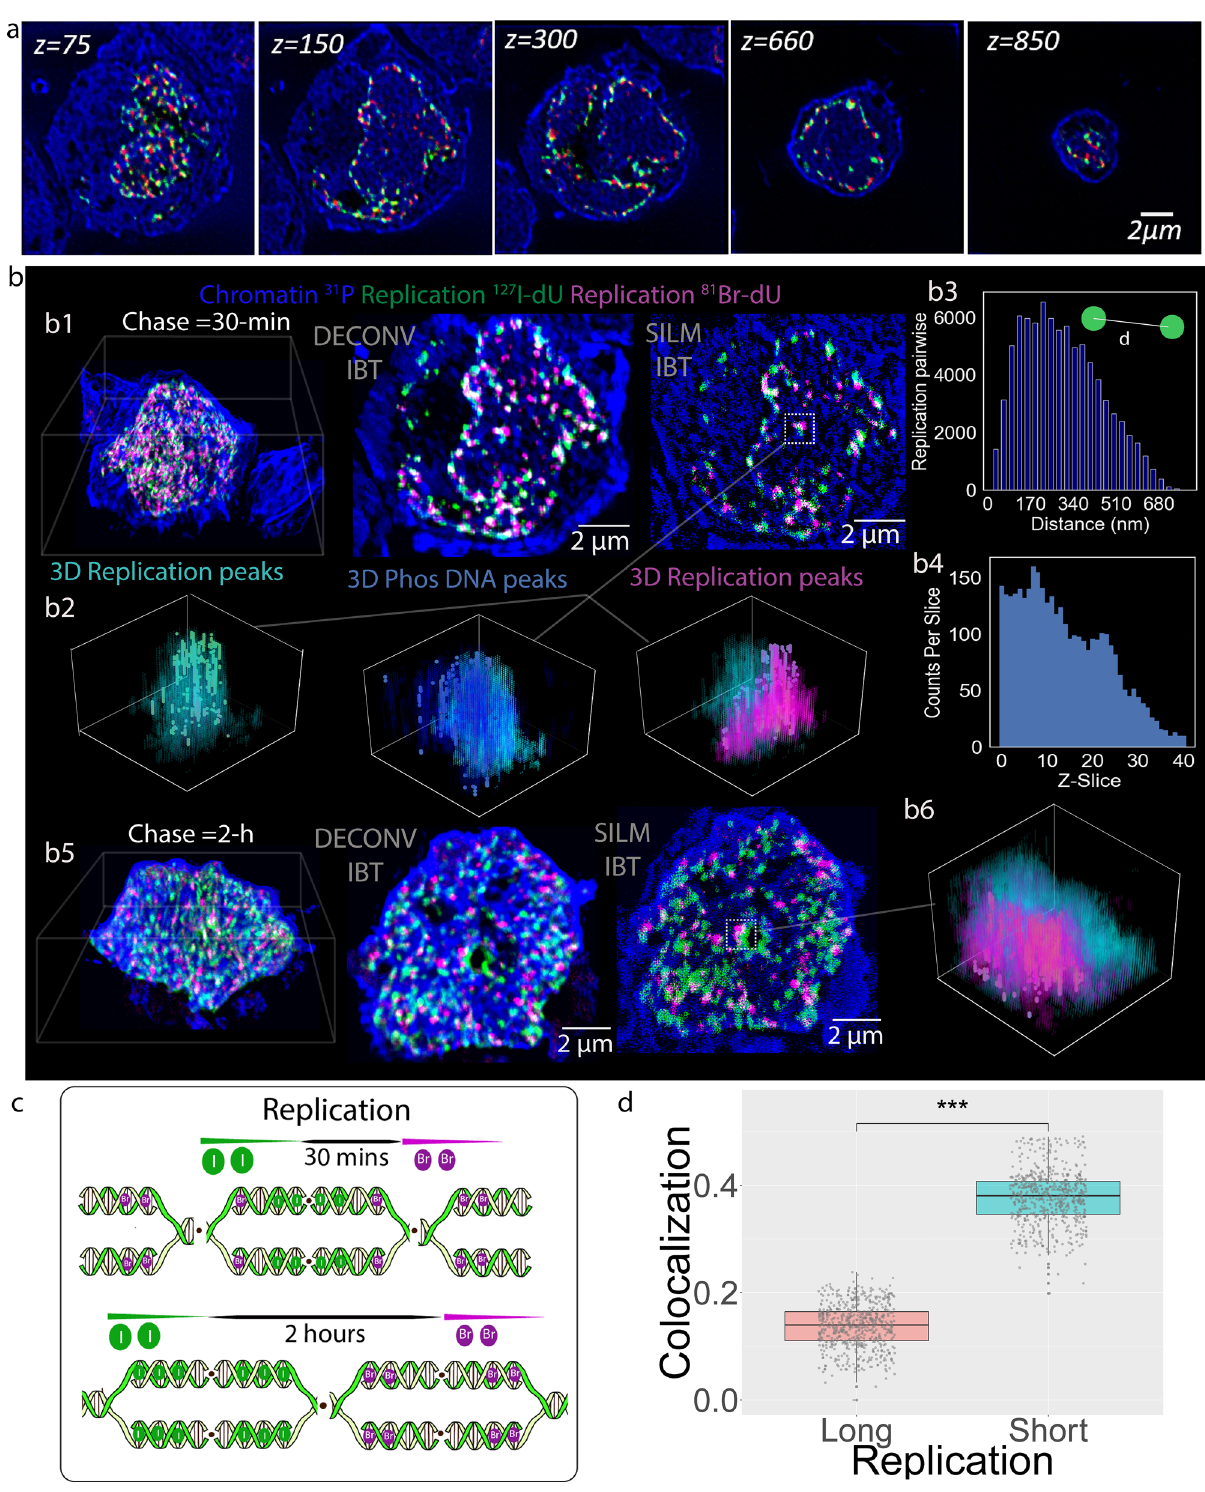
observed at depth levels ranging from 50 to 350 slices (Supplementary Fig. 43c). Ion-beam tomographic RNA images were then visualized by 3D rendering (Supplementary Fig.